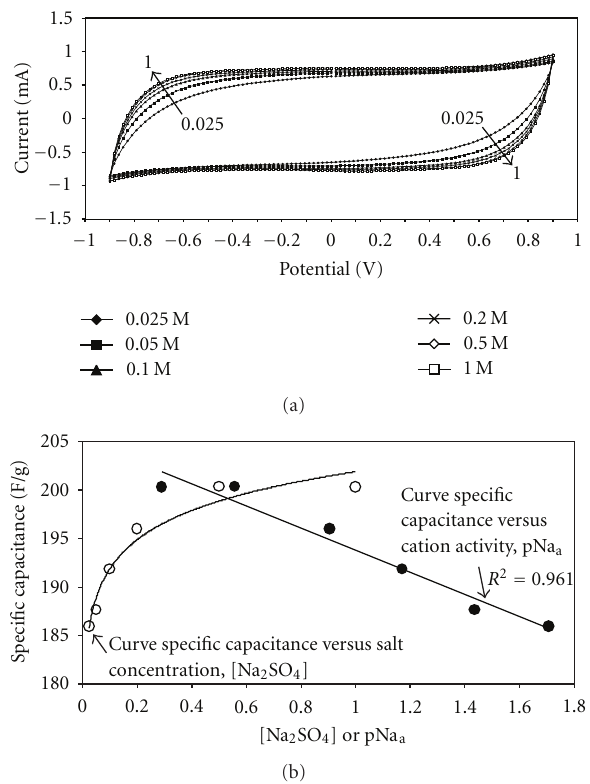
Figure 10: (a) Cyclic voltammograms in di ff erent Na 2 SO 4 elec- trolyte concentration at a scan rate of 50mV/s, (b) specific capacitance (F/g) of the MnO 2 EC prototypes at di ff erent electrolyte concentration, [Na 2 SO 4 ], and cation activity, pNa a